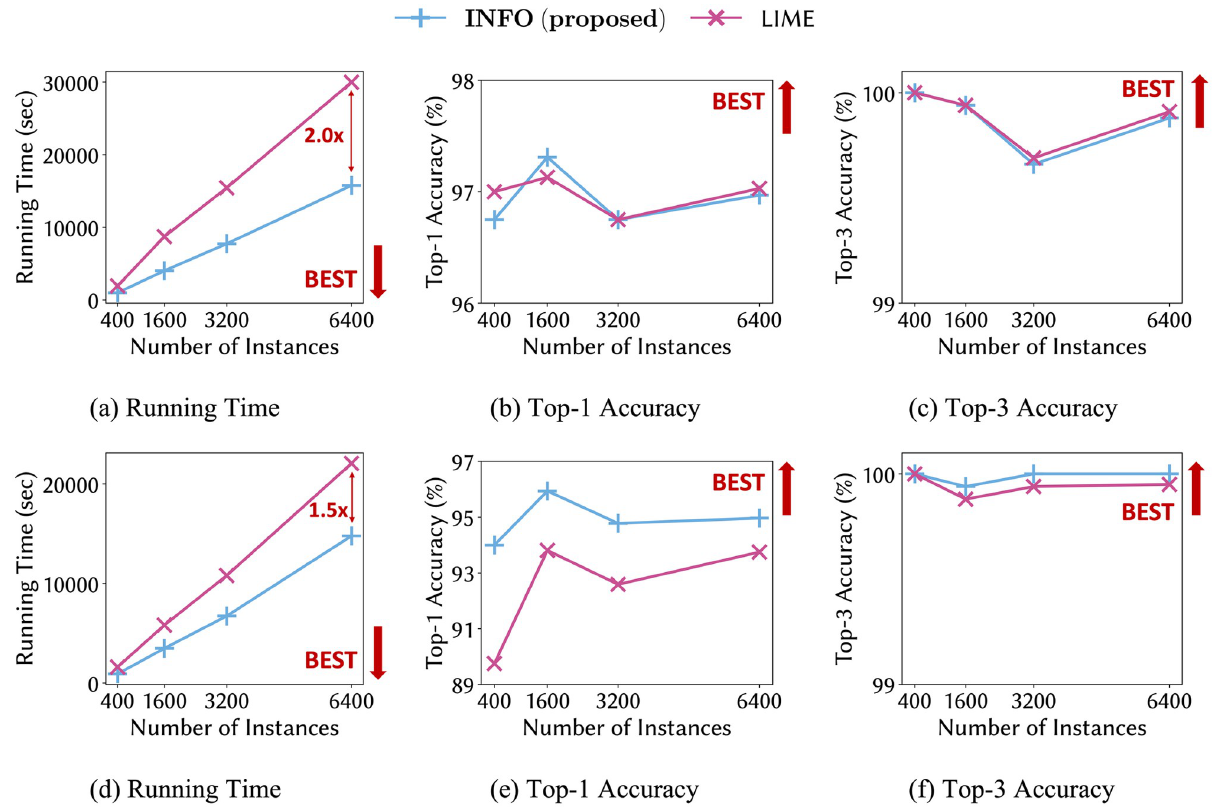
Fig 6. Running time and accuracy for INFO and LIME. (a-c) and (d-f) show performance on SEC-seq and Memtest86-seq datasets, respectively. INFO is up to 2.0 × and 1.5 × faster than LIME while having similar Top-1 and Top-3 accuracies for SEC-seq and Memtest86-seq datasets, respectively.